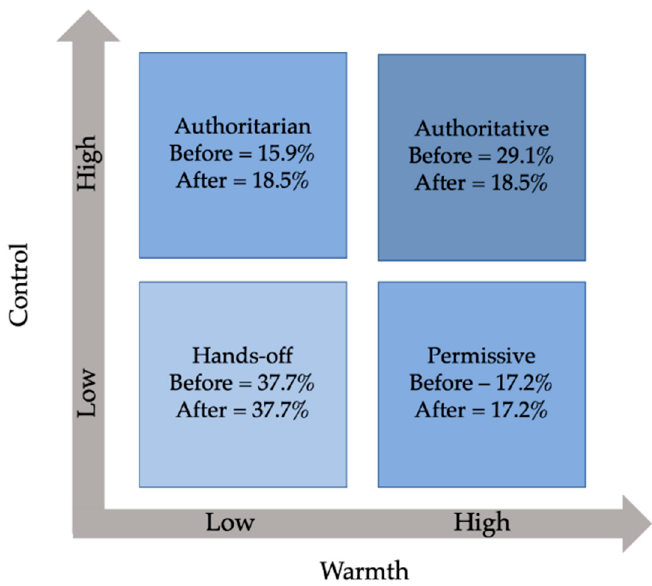
Figure 2. Dimensions of dog-directed interaction behavior by handlers.